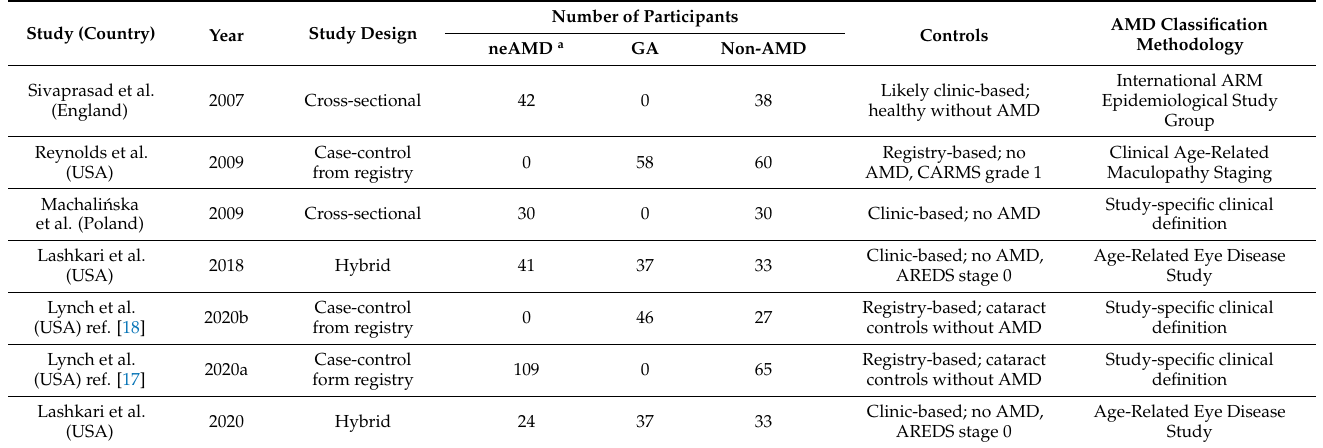
Table 1. Characteristics of the Studies Included in the Meta-Analysis.